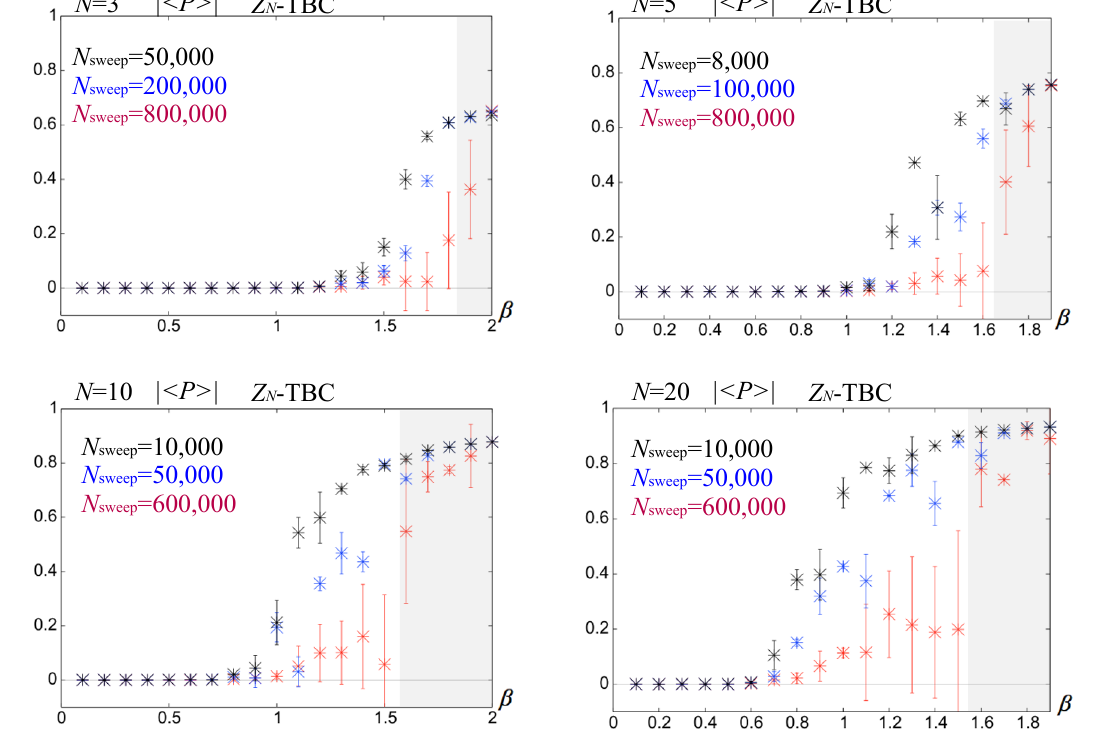
Figure 7 . Expectation values of the Polyakov loop jh P ij for N = 3 ; 5 ; 10 ; 20 and ( N s ; N (cid:28) ) = (200 ; 8) with di(cid:11)erent numbers of samples in Z N -TBC. The gray-shaded parts indicate the region at which the number of samples are less than the auto-correlation time. In such a high (cid:12) region, larger statistics tend to give smaller expectation